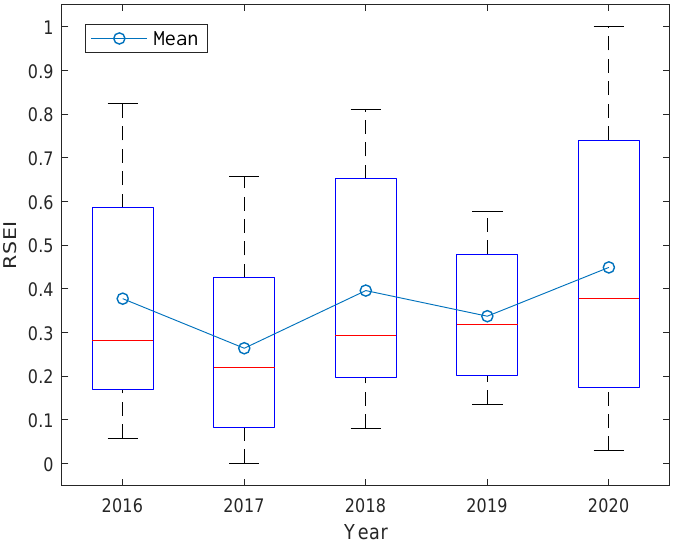
Figure 16. Box plots of